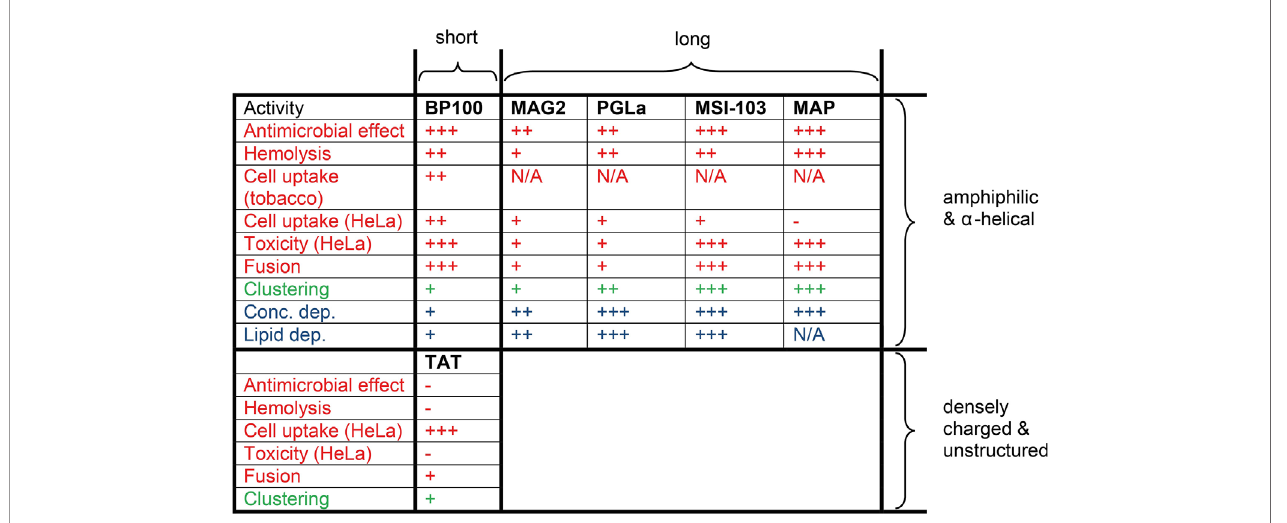
FIGURE 5 | Overview of all available results on the different membrane-active peptides. Short peptides contain only 11-14 amino acids, while the long ones consist of 18-23 amino acids. The newly measured activities are shown in red; previously reported lipid clustering is indicated in green [from ref. (Wadhwani et al., 2012a)]; and in blue we state whether any structural changes are known to take place as a function of peptide concentration or lipid composition, according to previous NMR and OCD analyses. The effects are coded as: (-) negligible effect, (+) low effect, (++) medium effect, (+++) strong effect, (N/A) no data